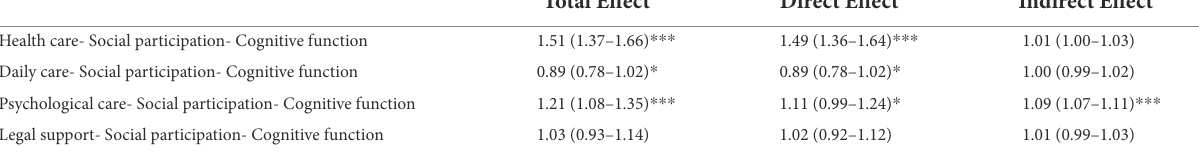
TABLE 5 Regression results of KHB mediation effect, OR (95%